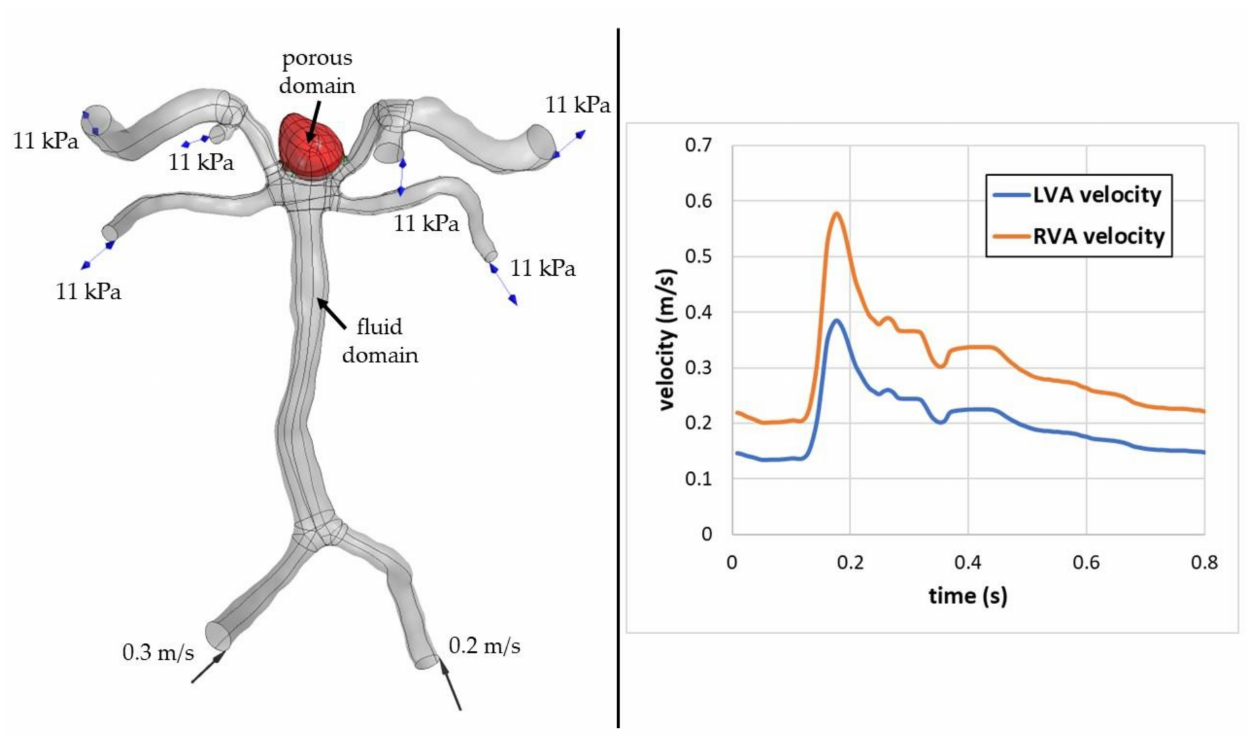
Figure 2. Numerical domain of the analysed case and transient inflow boundary conditions.